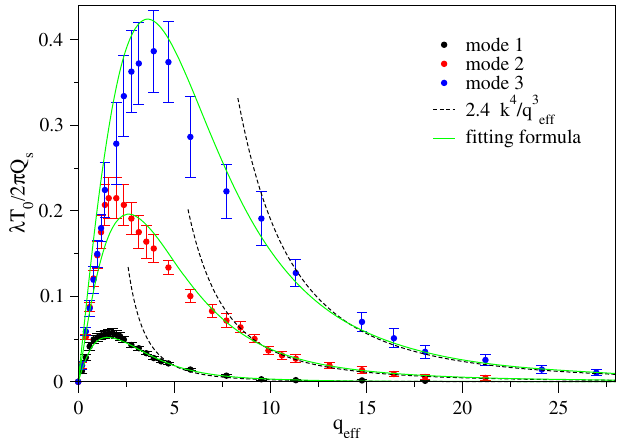
FIG. 6. 3D-G bunch. The Landau damping for modes 1, 2, and 3 versus the space charge parameter q damping increases quickly with increasing q space charge regime, q > ≈ 4 k , we find that λ T 0 ≈ 2 . 4 k where k is the mode number (dashed lines). This behavior is in agreement with the theoretical predictions [6]. The proportion- ality factor of 2.4 is characteristic of transverse Gaussian beams. The damping rates of all three modes can be fitted reasonably well for the entire range of the space charge strength by employing Eq. (33) (green lines).